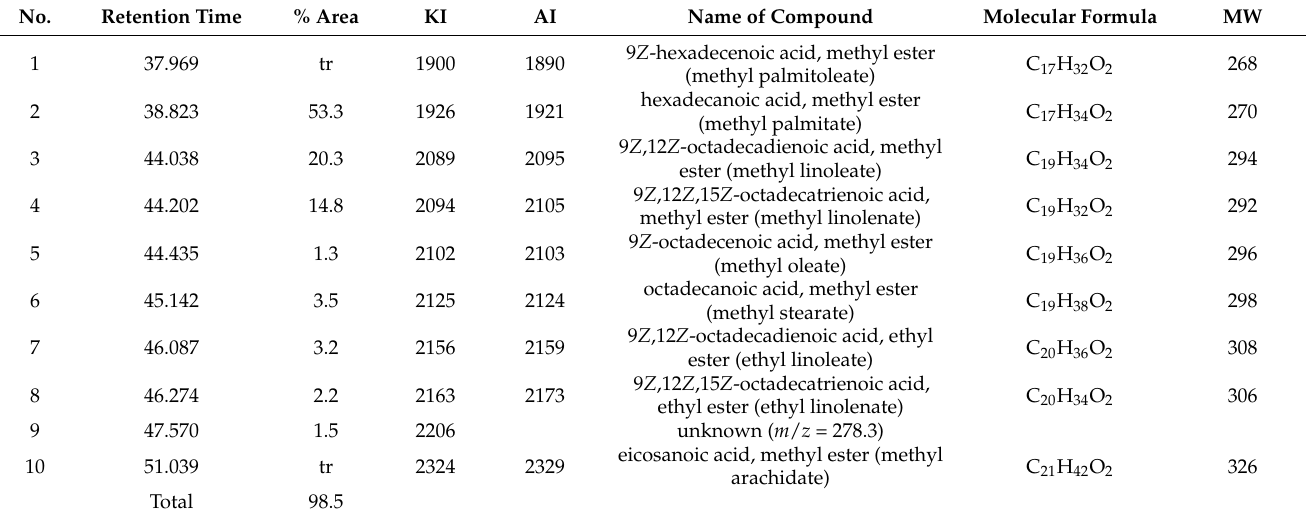
Table 3. Chemical composition of diethyl ether extract of Dioscorea communis berry juice after acid hydrolysis (A2A).